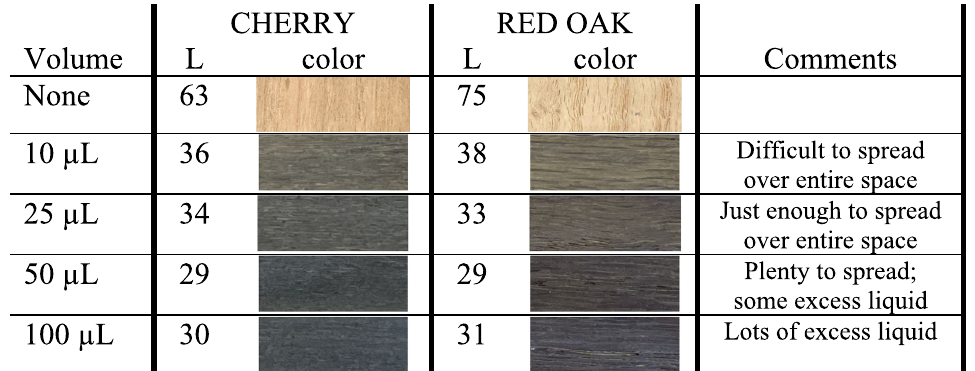
Fig. 6 Cherry and red oak veneer treated with varying volumes of 0.125 M iron acetate solution, the product of aged Rhodes steel wool–DW white vinegar reaction. The brown to black color of the ebonized wood was measured by reflectometry using the CIELAB system. The largest changes, as reported, were along the L